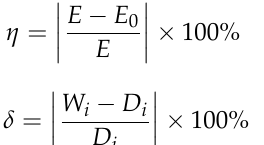
Table 4. The modulus back calculation accuracy.